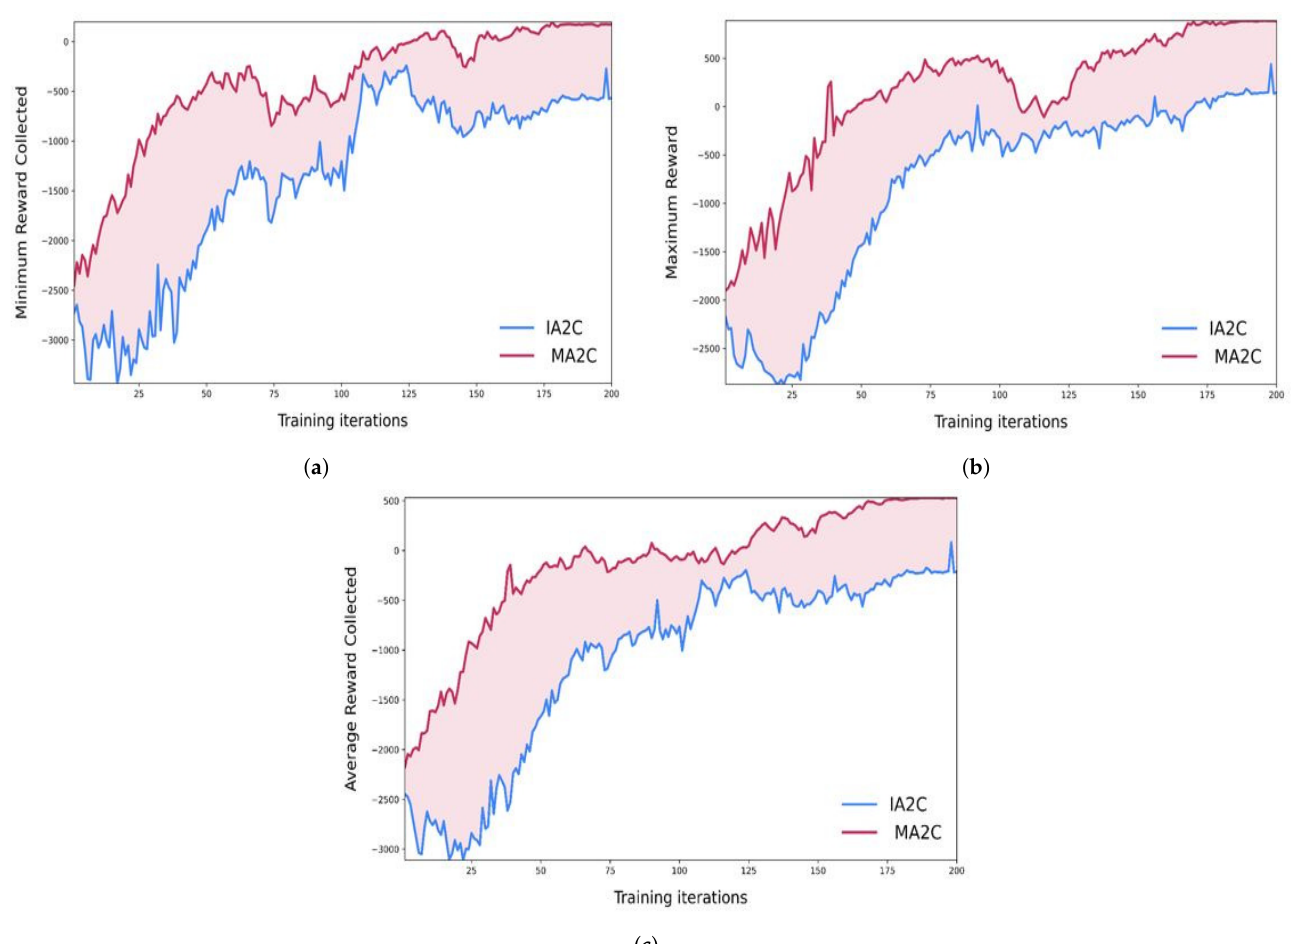
Figure 5. Results of reward value comparisons. ( a ) Minimum Reward Comparison for IA2C and MA2C. ( b ) Maximum Reward Comparison for IA2C and MA2C. ( c ) Average Reward Comparison for IA2C and MA2C.